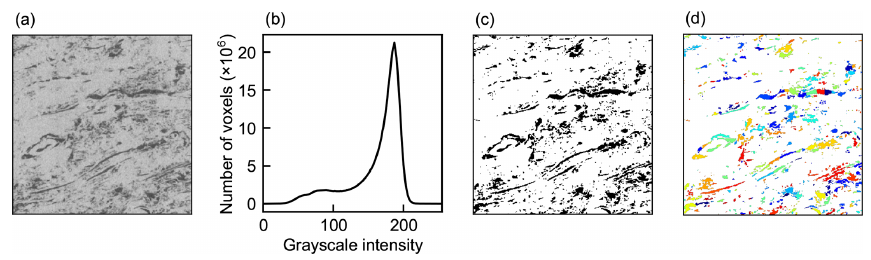
Figure 1. (a) Vertical slice of a 600 3 -voxel section of the noise-filtered X-ray micro-computed tomography image of one of the 40–45cm peat samples. (b) Histogram of the grayscale intensities of the corresponding noise-filtered cylindrical 8bit image with a height and diameter of 1000 voxels. (c) Vertical slice of the binary image resulting from solid–void segmentation. The white region denotes solid material (water and organic matter), and black regions denote void space (air). (d) Division of void space into individual pore regions.